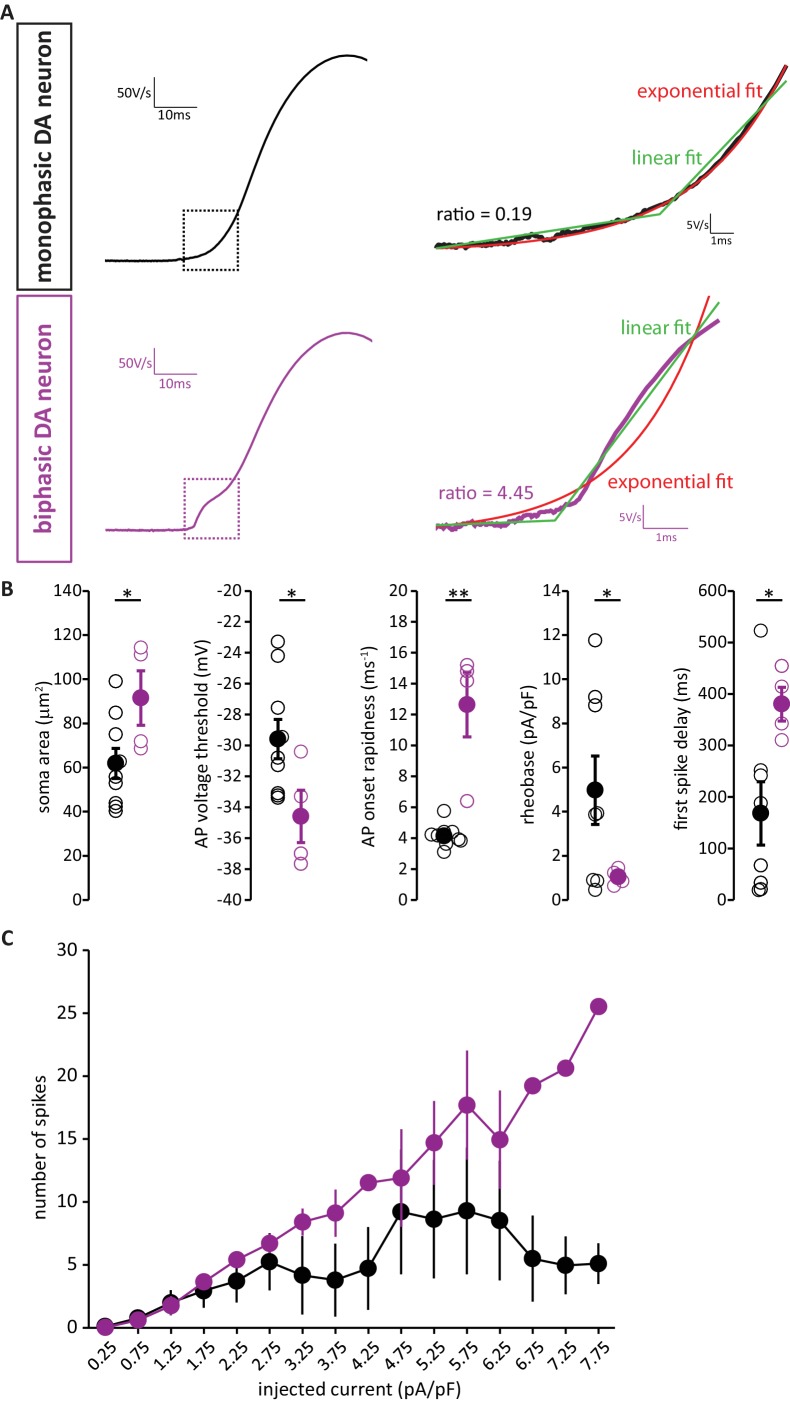
AIS-positive DA neurons also have greater intrinsic excitability with strict, objective phase plane plot classification.(A) Example current-clamp traces of phase plane plots of single APs fired by monophasic (AIS-negative, black, top) and biphasic (AIS-positive, magenta, bottom) DAT-tdTomato neurons. Dashed box indicates the AIS-dependent first action potential phase, which is shown at higher detail on the right and fitted with two methods. The ratio between the errors of the linear fit (green) and the exponential fit (red) is indicated near the trace. (B) Quantification of soma area (t-test; p=0.04), voltage threshold (t-test; p=0.046), onset rapidness (Mann-Withney test; p=0.003), rheobase (t-test; p=0.039) and first spike delay (t-test; p=0.0431) in monophasic and biphasic cells. Empty circles show values from individual cells, filled circles show mean ± SEM; *p<0.05; **p<0.01. (C) Input-output curve of injected current density versus mean ±SEM spike number for each group.